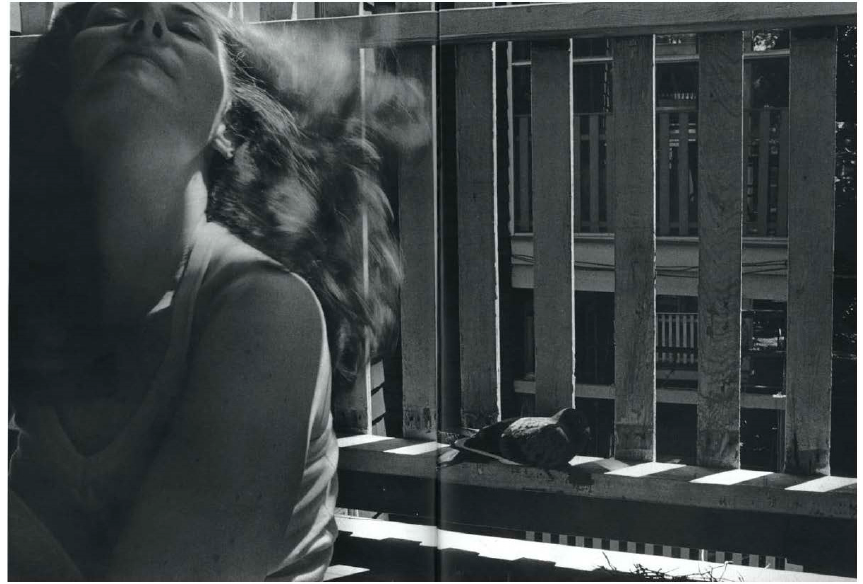
Figure 2. Courtesy Eugene Richards, Exploding into Life.